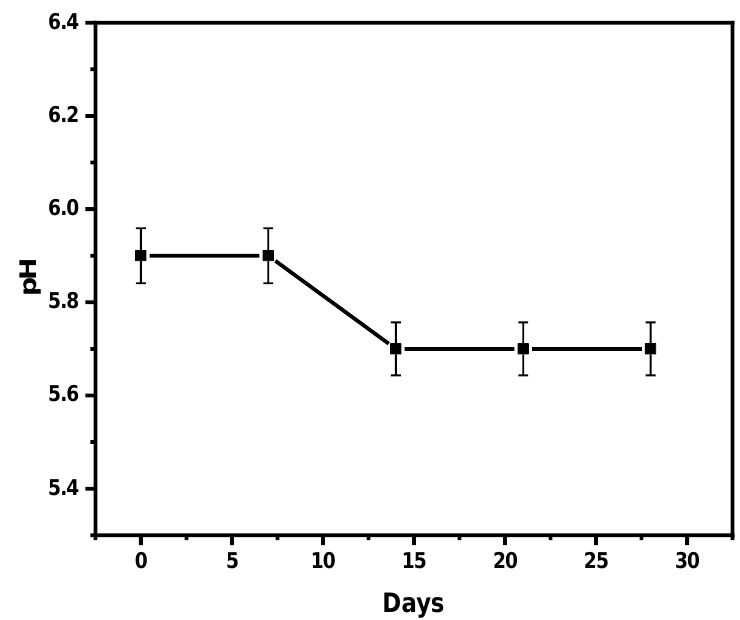
Figure 1. Evaluation of pH of AEOs emulgel-based transdermal formulation for 28 days.